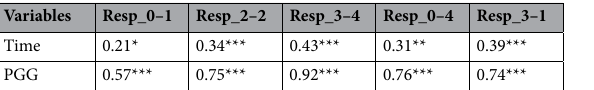
Table 7. OLS estimates for specification (8). *p < 0.05, **p < 0.01, ***p <